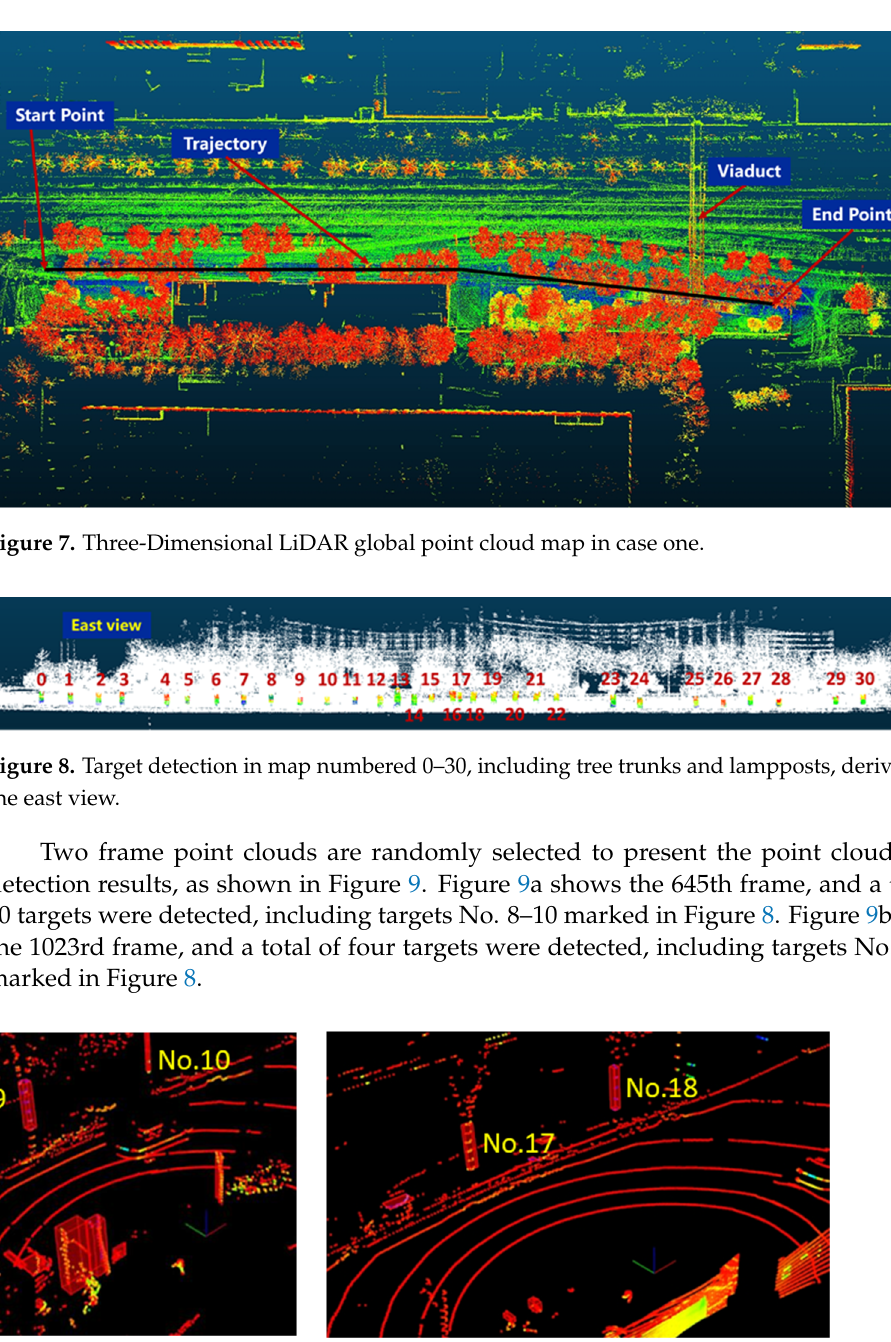
Figure 6. Trajectory and positioning errors in the east and north. ( a ) The trajectory of the vehicle in case 1. ( b ) The positioning errors in the east and north.